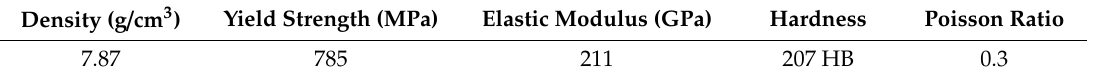
Figure 2. Details of the specimens. Table 1. Material properties of 40 Cr steel.